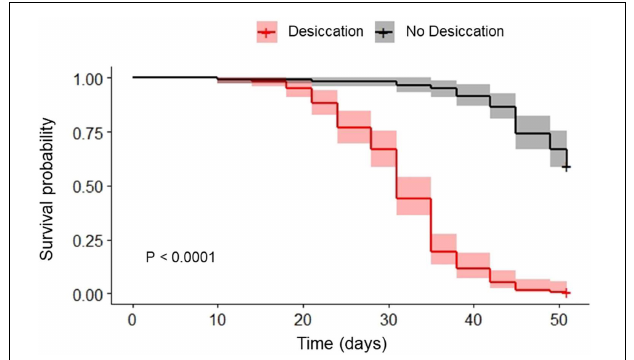
FIGURE 1 | Survival probability of food-deprived adults of Alphitobius diaperinus kept at 10 ± 2% RH (desiccation, gray line) and their relatives kept at approximately 60% RH (no desiccation, black line). P -value resulting from log-rank test comparing the two Kaplan Meier plots is presented, as well as the 95% confidence intervals for each survival curve. “+” at the end of the survival curves indicate that data were censored.